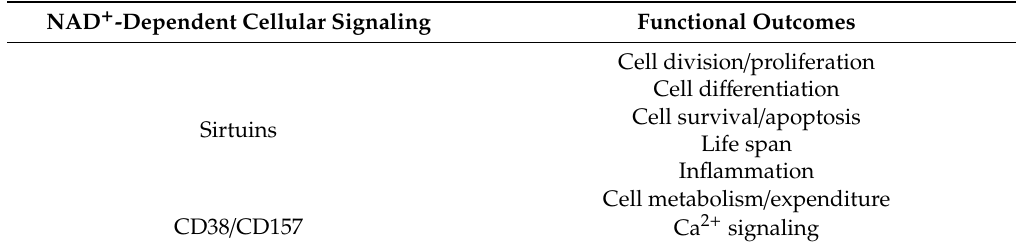
Table 1. Functional role of intracellular visfatin